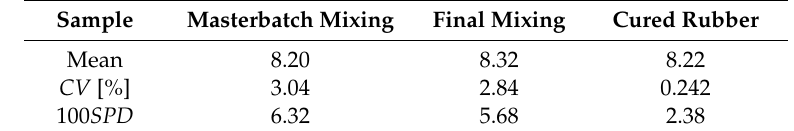
Figure 11. THz absorbance spectra at 25 measured point in various sample condition. ( a ) Silica masterbatch mixing (unvulcanized), ( b ) final mixing (unvulcanized), and ( c ) vulcanized rubber. Inset shows each THz absorbance image. Table 3. The averaged THz absorbance, CV, and 100SPD for masterbatch mixing, final mixing, and vulcanized rubber.